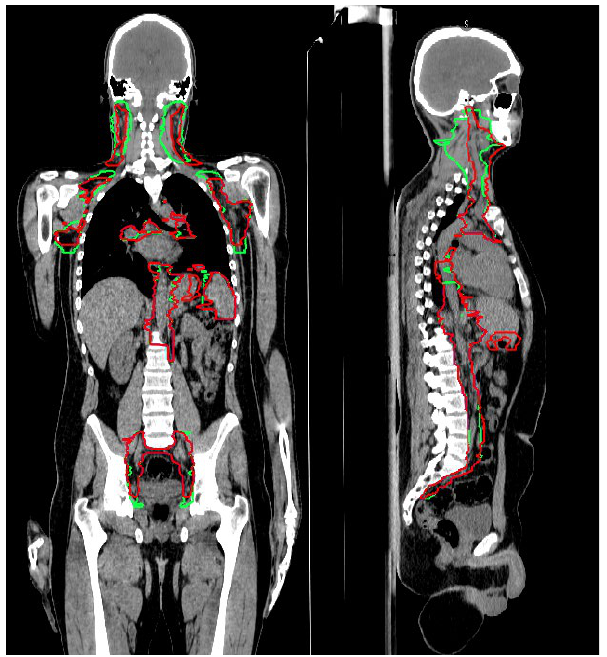
Figure 2. Coronal and sagittal views of CTV_LN contouring, before (green segmentation) and after (red segmentation) the guidelines’ introduction. Table 3. CTV_LN and lymph node substructure volume analysis, before and after the guidelines’ introduction; the minimum and maximum values are reported in